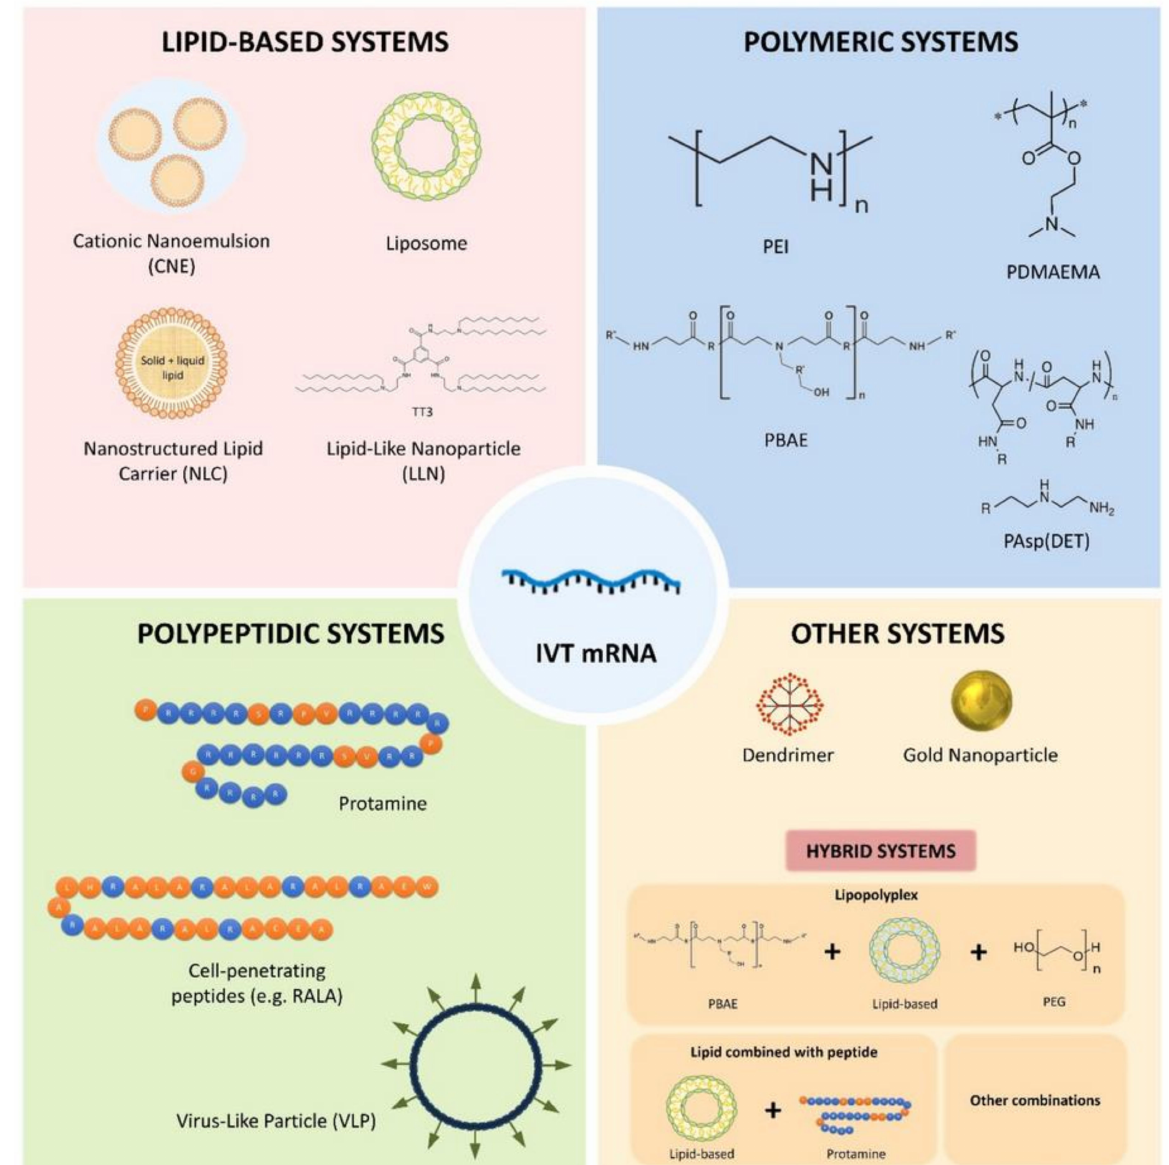
Figure 4. The as-yet studied mRNA vaccine nanocarriers. Reproduced with permission [38]. Subunit vaccine carriers : Subunit vaccines comprise very limited structural com- ponents of SARS-CoV-2, able to induce protective immune reactions in the body, upon subunit vaccines can be made via incorporation of viral proteins in protein cages, virus-like particles (VLPs), and synthetic nanomaterials, performing as delivery carriers and/or adjuvants [39–41]. For instance, influenza protein haemagglutinin incorporated liposome is the basis of the influenza virus vaccine Crucell (Janssen, Johnson & Johnson) [42]. The subunit vaccine nanocarriers provide antigen multivalency and allow optimum concurrent delivery of adjuvant and antigen to secondary lymphoid organs [43]. Furthermore, thanks to their specific size scale, they enable lymphatic trafficking and favorable uptake by the antigen presenting cells (APCs). They induce depot effects for stable immune stimulus and ease the antigen cross presentation, that allows the extracellular antigens to be presented via the MHC-I pathway for CD8 + T cell engagement